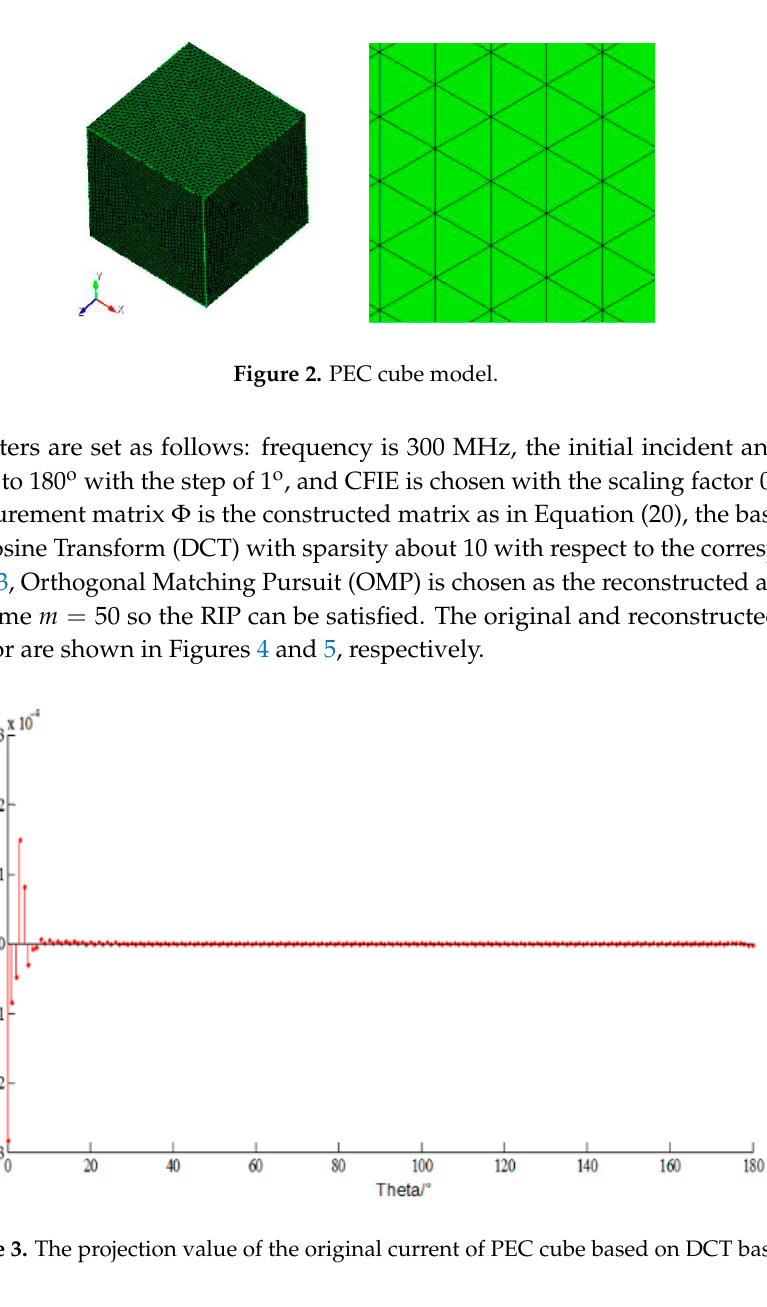
Figure 4. The current of PEC cube by multilevel fast multipole acceleration (MLFMA) and MLFMA with compressive sensing (CS) based on DCT basis. Figure 5. The relative error of the current of PEC cube by MLFMA and CS-MLFMA based on DCT basis. It can be seen the relative errors in Figure 5 are almost under 10 (cid:2879)(cid:2871) , and the RCS by MLFMA and CS-MLFMA are provided in Figure 6, where the error of the reconstruction can be considered acceptable.